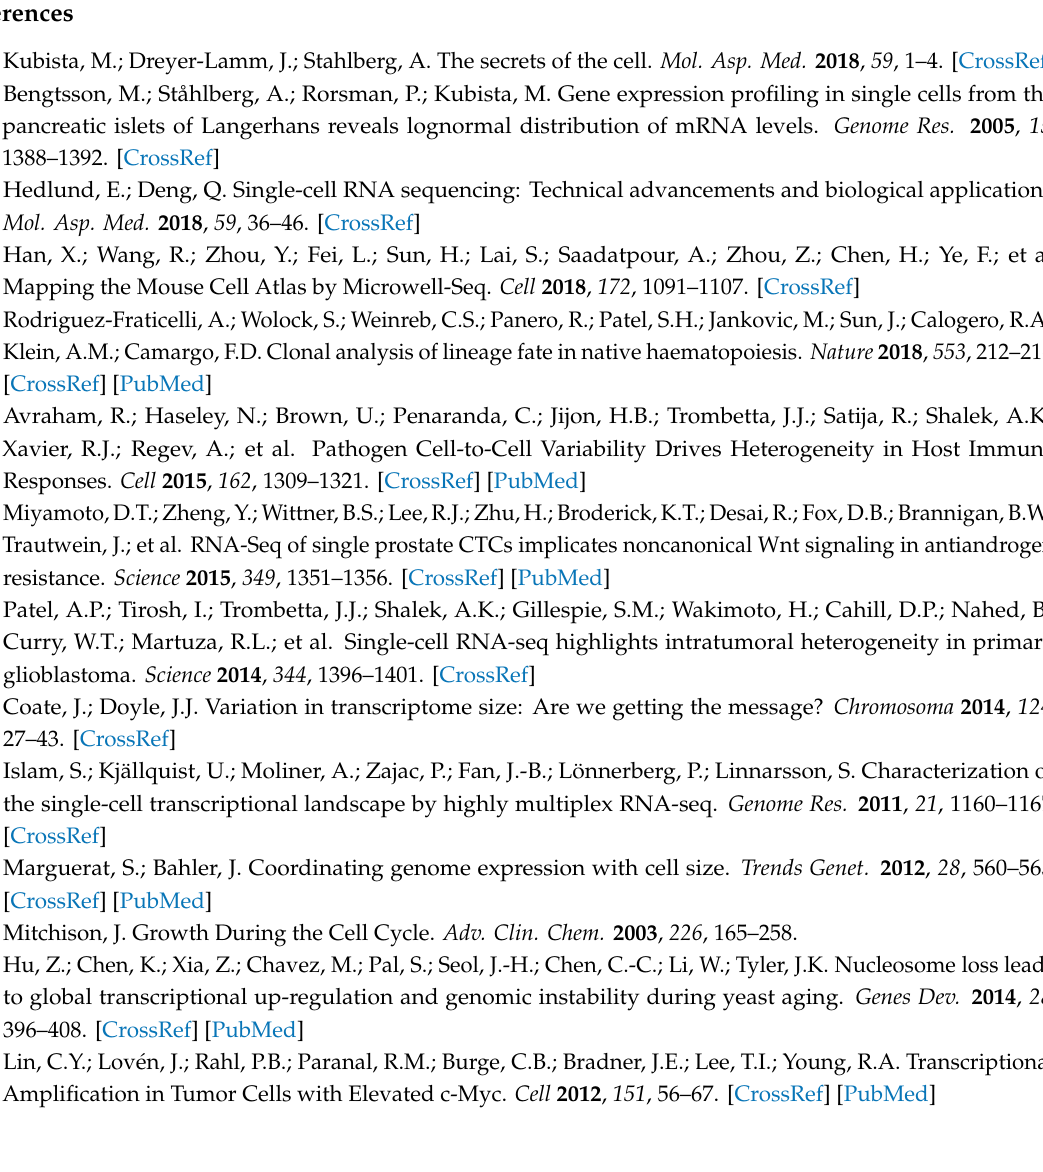
Figure S1: Size distribution assessment of preamplified cDNA, Figure S2: Preamplification and melting curves, Table S1: Pairwise statistical comparisons of relative expression levels between cell